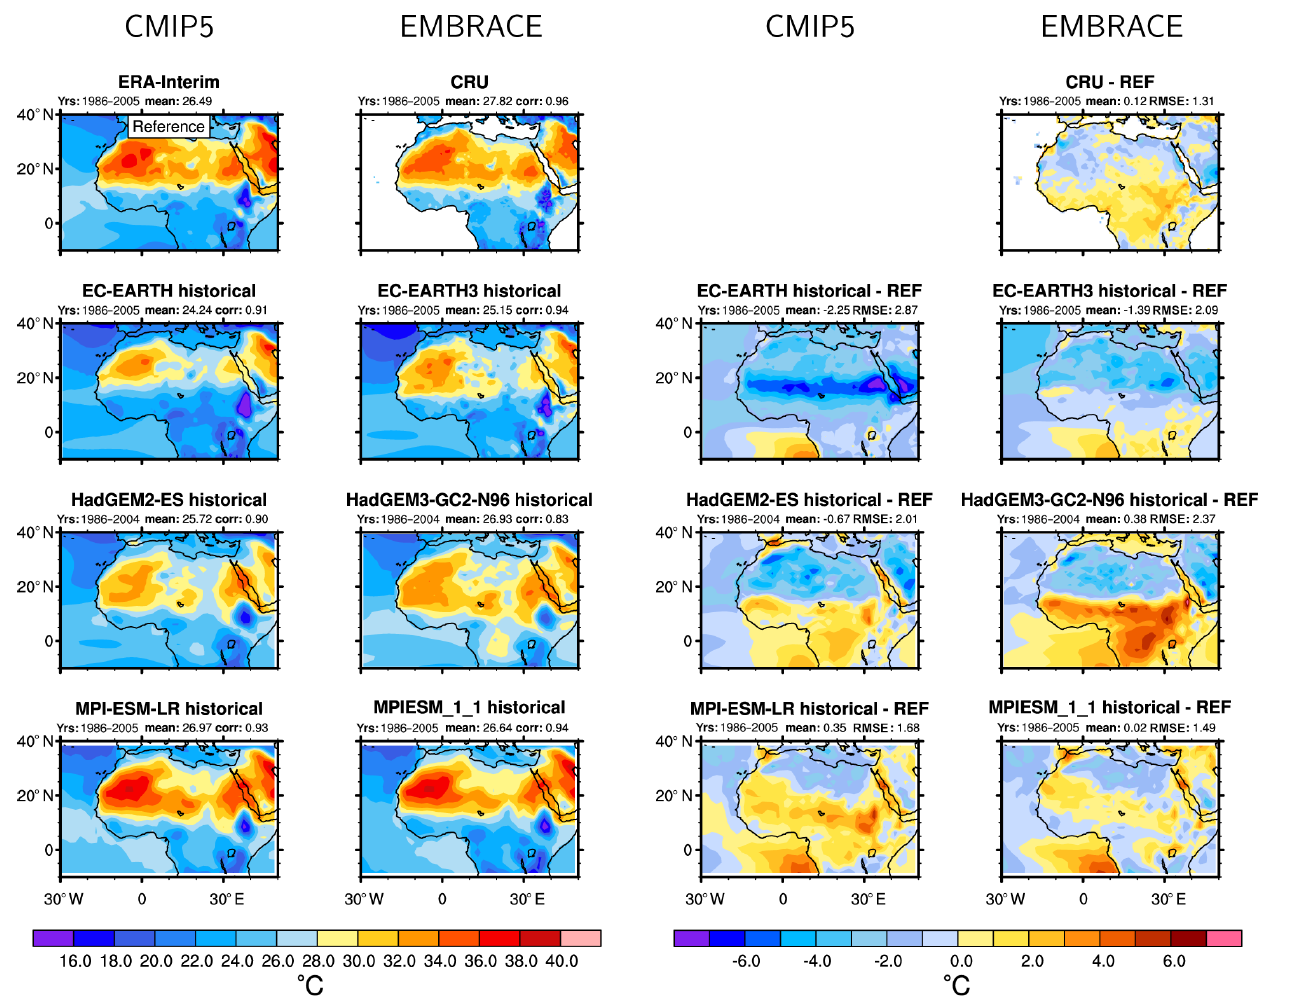
Figure 8. Leftmost two columns: seasonal mean 2m temperature for JJAS from reanalysis data (ERA-Interim), the CRU dataset, and the coupled simulations averaged over the years 1986–2005 (HadGEM: 1986–2004). Rightmost two columns: differences relative to ERA- Interim. Columns 1 and 3 show the original CMIP5 model versions, columns 2 and 4 the EMBRACE-updated models. The domain-averaged annual mean (“mean”), linear pattern correlation (“corr”; leftmost two columns), mean bias (“mean”), and root mean square error (RMSE; rightmost two columns) compared with ERA-Interim are given above the individual